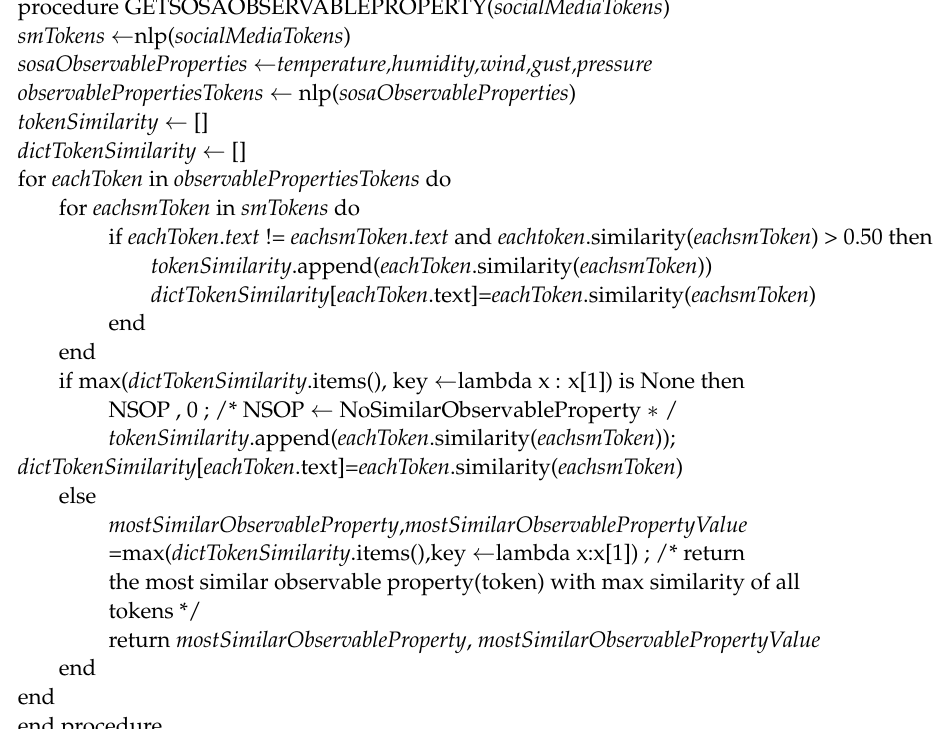
Algorithm 1: Match social media posting with sosa:observable property procedure GETSOSAOBSERVABLEPROPERTY( socialMediaTokens